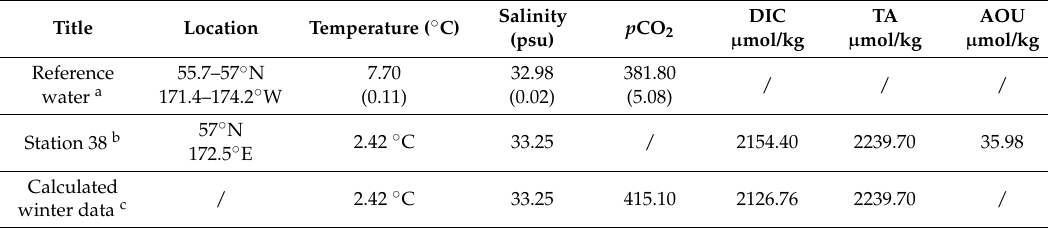
Table 2. Values for the different parameters in the reference water mass and water in the minimum temperature layer in the summer. Data in the parentheses are the standard deviation from the average values of N = 238 data